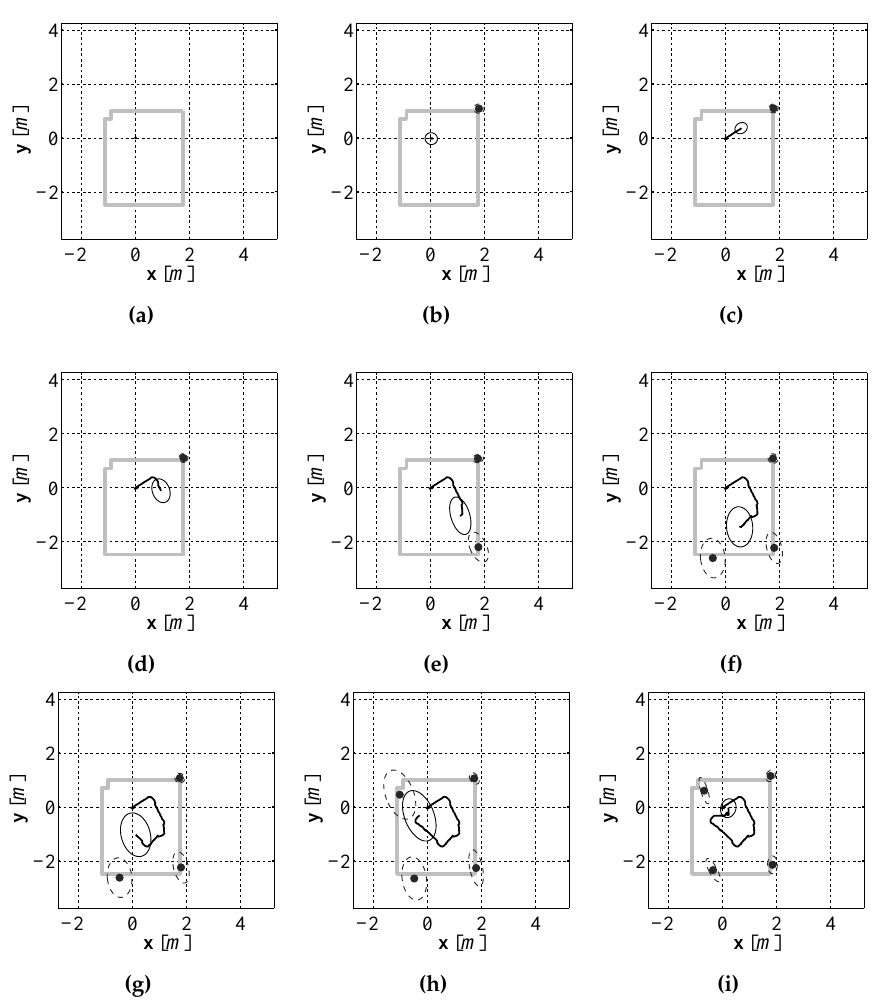
Figure 26. Evenly spaced sequence of path and map estimates, ( a )–( i ), produced by the FastSLAM